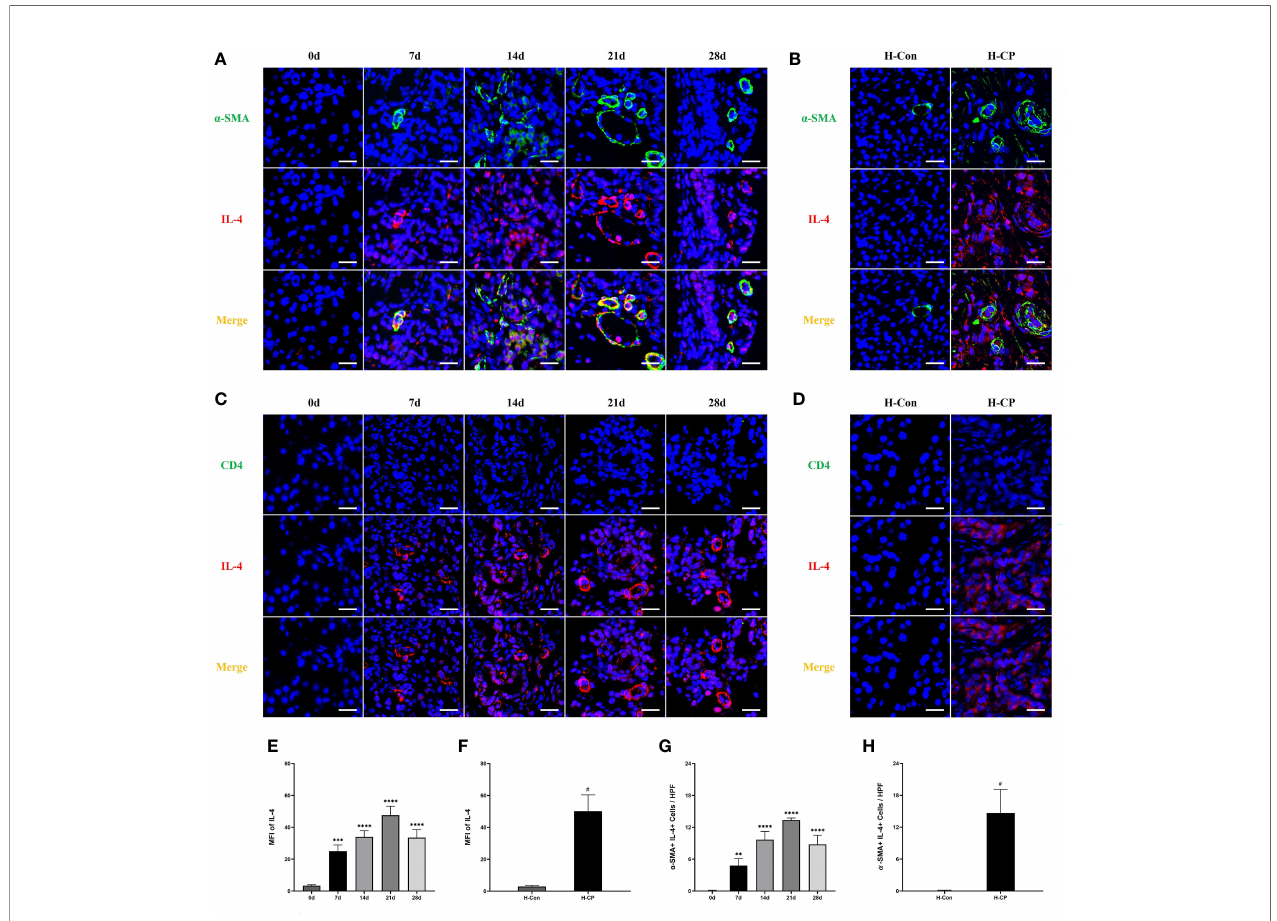
FIGURE 7 | The expression of IL-4 increased in human CP specimens, as well as in mice CP models as the disease progressed and peaked at 21d. A large number of a -SMA+IL-4+cells, which represents PSCs secreting IL-4, were found in the pancreas of mice CP models and human CP. However, almost no CD4+IL-4+cells in the pancreas of mice CP models and human CP were observed. (A, C) Immuno fl uorescence staining of pancreatic IL-4 co-localized with a -SMA or CD4 in mice model of pancreatitis at different time points. (B, D) Immuno fl uorescence staining of pancreatic IL-4 co-localized with a -SMA or CD4 in human specimens. (E) MFI of pancreatic IL- 4 at different time points in mice. (F) MFI of pancreatic IL-4 at different time points in human specimens. (G) a -SMA+IL-4+cells counts per HPF in mice. (H) a -SMA+IL-4 +cells counts per HPF in human specimens. Values are shown as means ± SE. n = 3 per group. **P < 0.01, ***P < 0.001, ****P < 0.0001 versus 0d. # P < 0.05 versus H- Con. Scale bar=20 m m. H-CP, human chronic pancreatitis; H-Con, human control; MFI, mean fl uorescence intensity; HPF, high-powered fi eld of